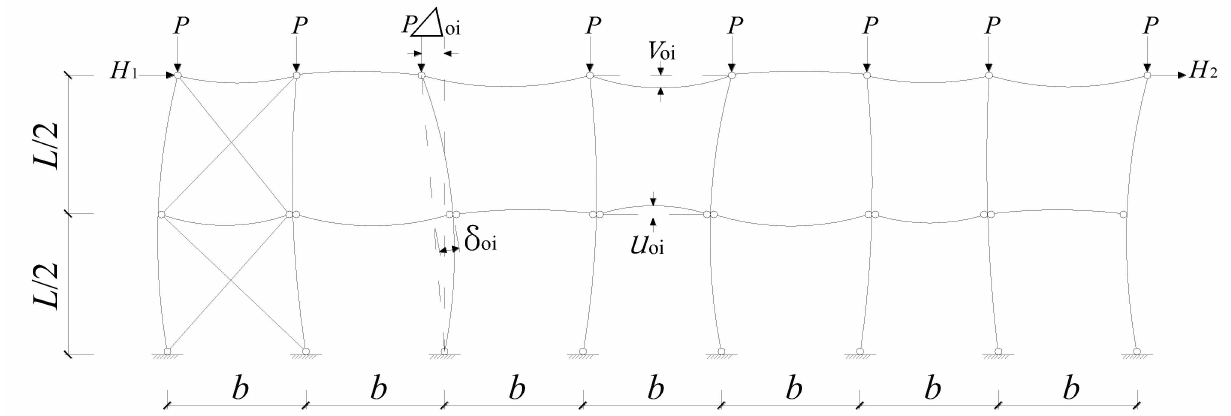
Figure 4. The initial bow and sway imperfection of the column, the initial imperfection of the intermediate-height horizontal brace, and the initial imperfection of the i th top horizontal